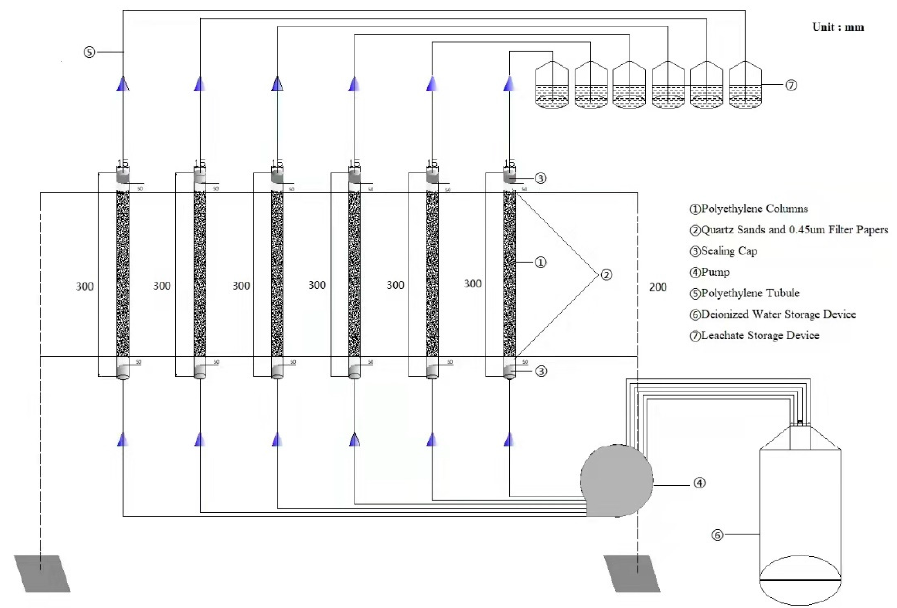
Figure 1. Structure of column